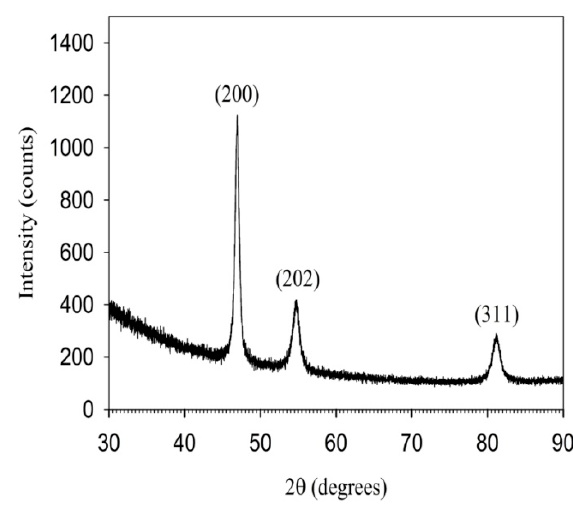
Figure 9. X-ray Diffraction (XRD) pattern of Bio-PdNPs . Figure 9. X-ray Di ff raction (XRD) pattern of